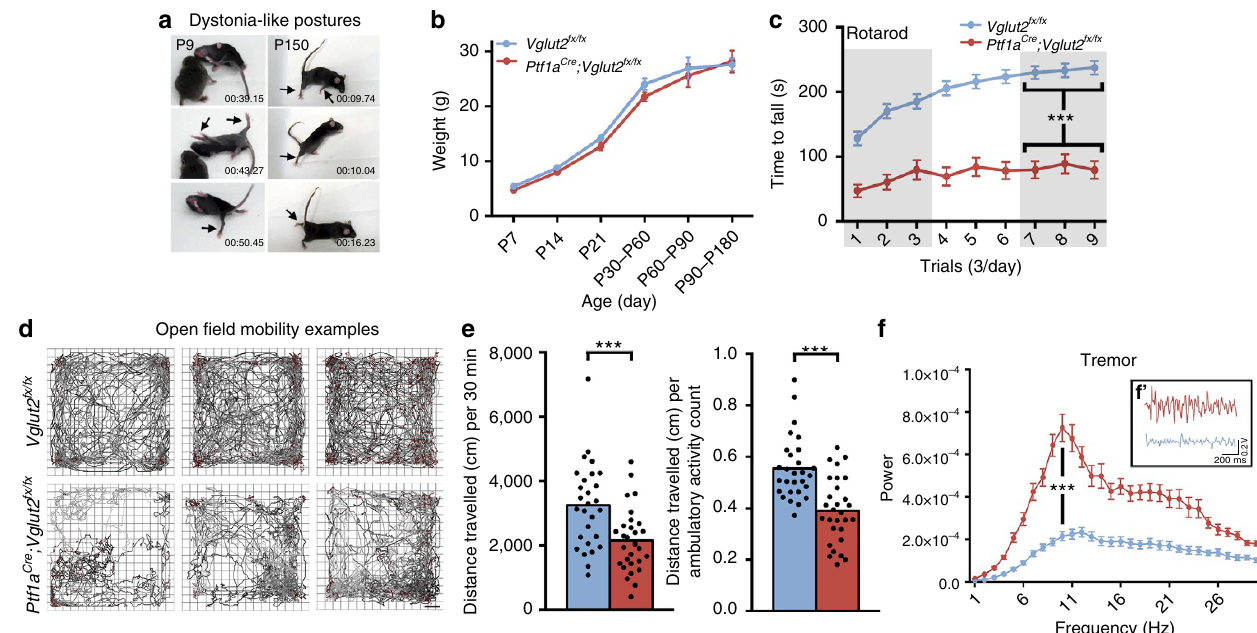
Figure 3 | Blocking climbing fibre function causes severe dystonia-like behaviours. ( a ) Serial stills of both early postnatal (with a control Vglut2 fx/fx littermate shown) and adult Ptf1a Cre ;Vglut2 fx/fx mice displaying dystonia-like postures. Mobility is severely impaired and their limbs are extended and stiff. Arrows identify extended, stiff limbs. ( b ) Weights of mice at different ages (postnatal day (P)7, P14, P21, P30–P60, P60–P90 and P90–P180) reveal no significant differences between control and mutant mice (at least 8 mice from each genotype for each age, gender-matched, Student’s unpaired t -test). Note that although movement is abnormal in the mutants, they are still capable of eating, exploring the cage and mating. Error bars are defined as s.e.m. ( c ) Rotarod performance is severely impaired in the mutant mice; n ¼ 62 Vglut2 fx/fx mice, 38 Ptf1a Cre ;Vglut2 fx/fx mice. Performance of the last day is significantly different between control and mutant mice ( P ¼ 1.746 (cid:2) 10 (cid:3) 14 ; Student’s unpaired t -test). Error bars are defined as s.e.m. ( d ) Examples of open field activity from three different Vglut2 fx/fx controls and three different Ptf1a Cre ;Vglut2 fx/fx mutant mice showing the range of performance for both genotypes. Scale bar, 5 cm. ( e ) Quantification of Vglut2 fx/fx ( n ¼ 28 mice) and Ptf1a Cre ;Vglut2 fx/fx ( n ¼ 29) open field mobility over a 30min period. The left graph shows a decrease in the total distance travelled in the mutants ( P ¼ 9.62 (cid:2) 10 (cid:3) 4 ; Student’s unpaired t -test) and the right graph shows a lower total distance travelled divided by the number of ambulatory events in the mutant mice ( P ¼ 7.20 (cid:2) 10 (cid:3) 6 ; Student’s unpaired t -test). Although the mutant mice exhibit periods of twisting with limited movement and sustained muscle contractions (see EMG in Supplementary Fig. 4d), they are typically capable of moving around albeit with impaired motion and altered posture (Supplementary Movie 3). ( f ) Tremor is significantly increased in Ptf1a Cre ;Vglut2 fx/fx mutant mice. Raw waveforms are passed through a fast Fourier transform and the results graphed as power versus frequency; n ¼ 139 Vglut2 fx/fx and 129 Ptf1a Cre ;Vglut2 fx/fx mice. Tremor in all mice was of similar frequency ( P ¼ 0.705; Student’s unpaired t -test). Amplitude is significantly higher in Ptf1a Cre ;Vglut2 fx/fx mice ( P ¼ 1.05 (cid:2) 10 (cid:3) 6 ; Student’s unpaired t -test). ( f 0 ) Raw tremor waveforms from Vglut2 fx/fx and Ptf1a Cre ;Vglut2 fx/fx mice. Error bars